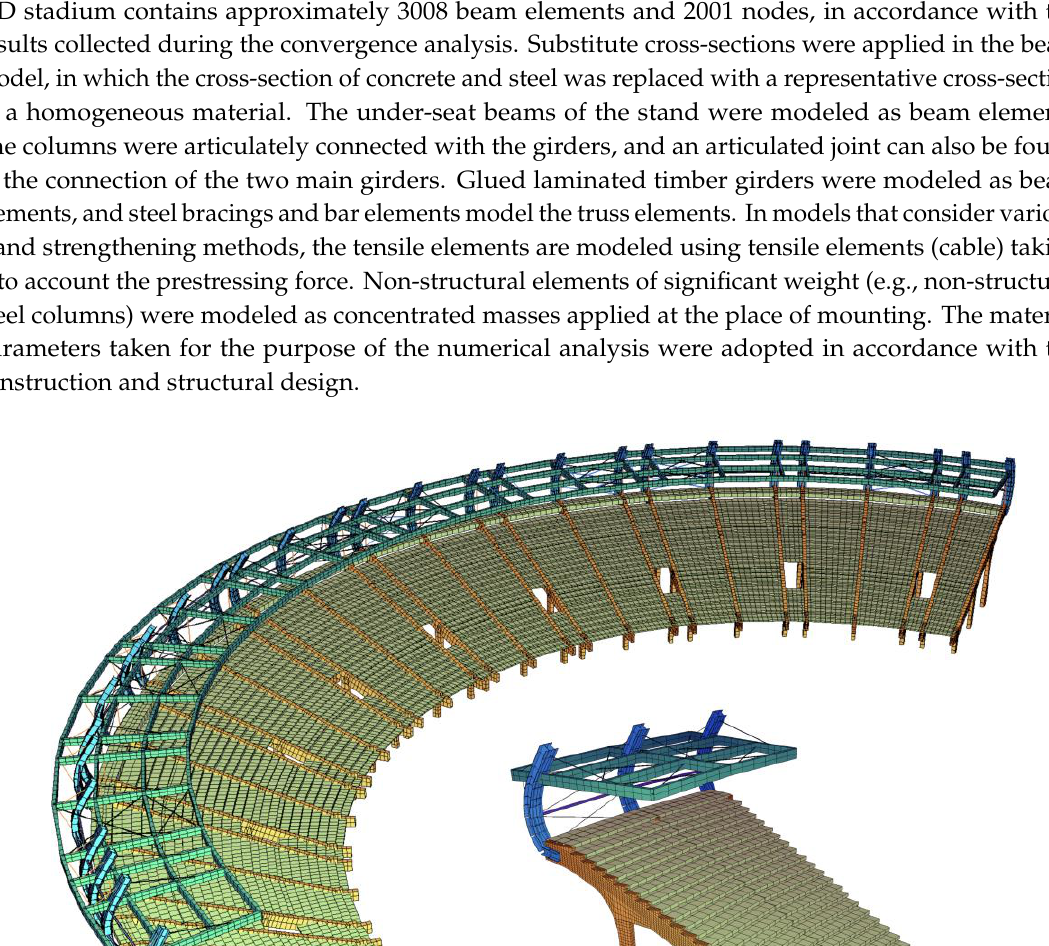
Figure 18. Mode shapes and frequencies of natural vibrations of a single stand section obtained from numerical simulations: ( a ) 3.48 Hz, ( b ) 3.90 Hz, ( c ) 4.65 Hz . The determined basic natural vibration frequency of the stand construction with a roof and without strengthening was used to simulate forced oscillations and to determine the degree of stiffness reduction of the concrete cross-section due to scratches. For the purpose of the analysis, the structure was loaded with its own weight and an evenly distributed load on the stands of 8.0 kN/m 2 , in accordance with PN-EN-1991-1-1 [27]. It was assumed that this load changes harmonically according the to the relation  ( ) sin( ) p t p t , where the amplitude p = 8.0 kN/m 2 and the circular frequency ω = 15.71 rad/s (which corresponds to the frequency f = 2.3 Hz). It has been assumed that the load of such nature lasts t = 60 s, the same as in the experiment.